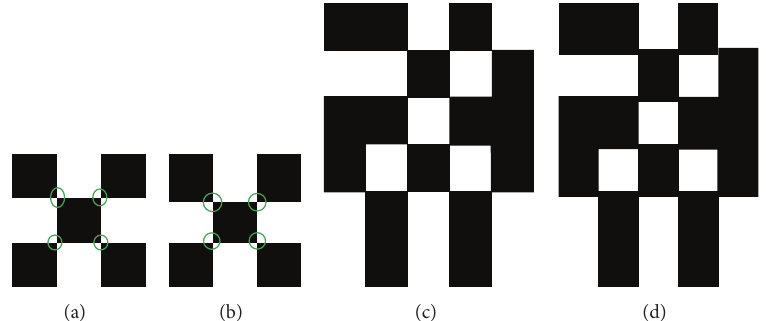
Figure 2: (a) Traditional on/off building blocks with infinitesimal connections. (b) Scheme with overlaps. (c) A possible structure with infinitesimal connections. (d) A possible structure with